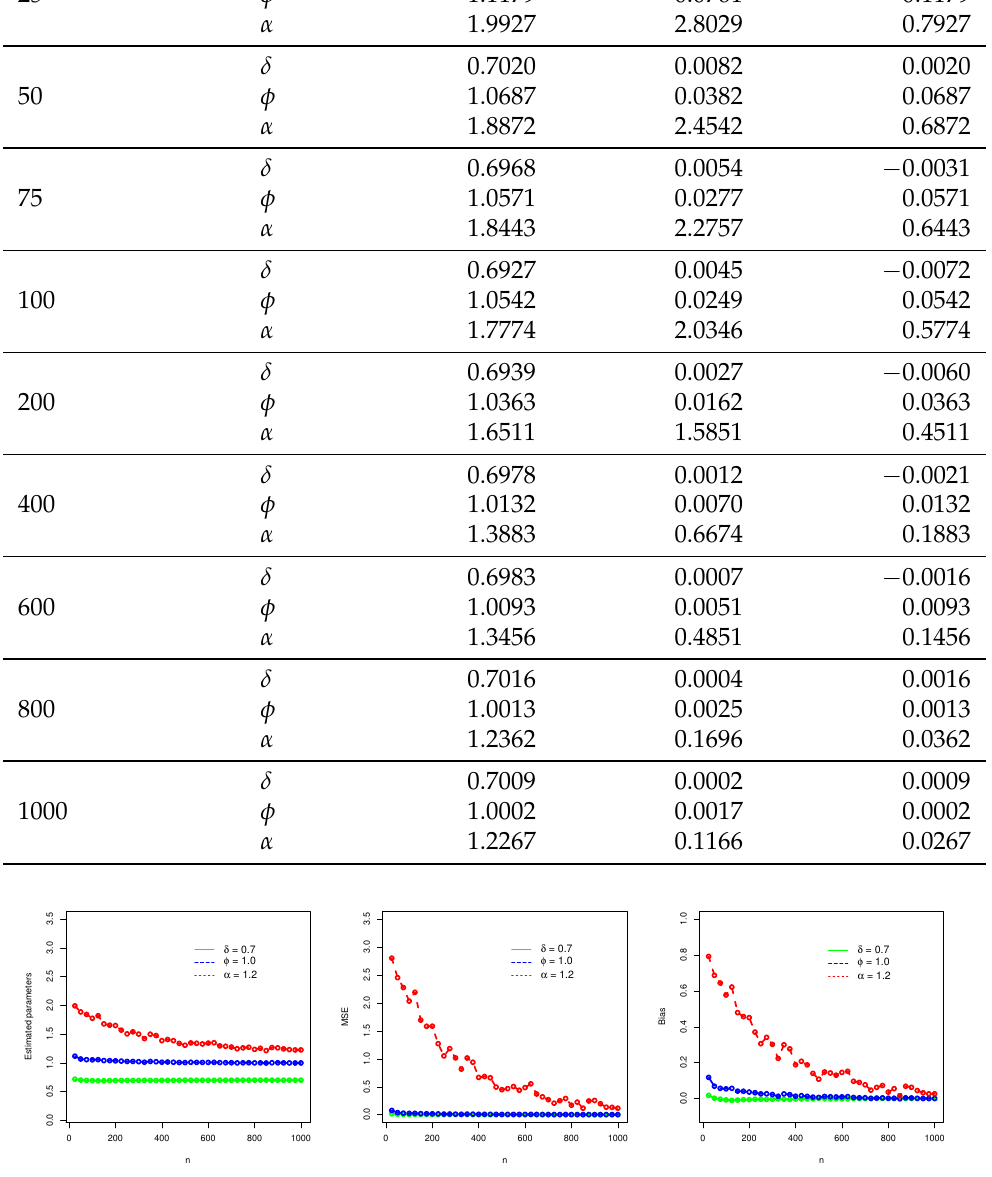
Figure 6. The visual illustration of the SS of the NACos-Weibull distribution for δ = 0.7, φ = 1.0, and α =